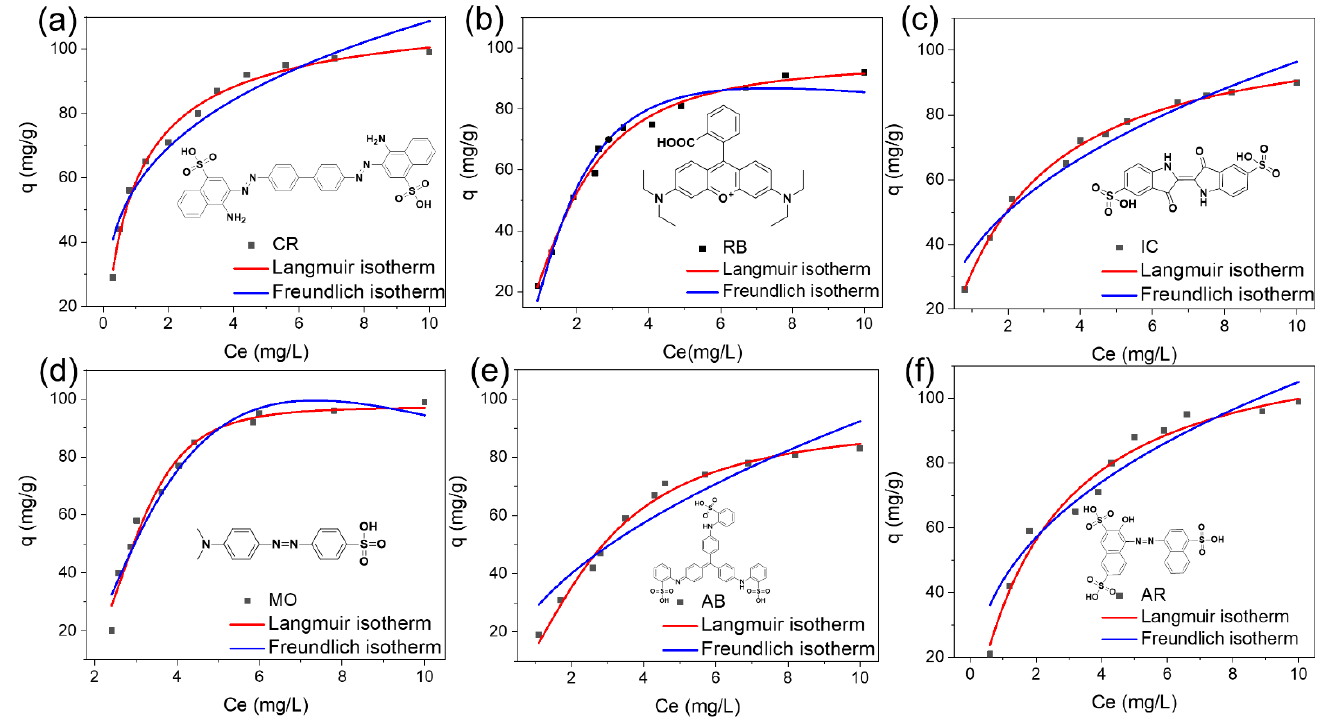
Figure 7. Adsorption isotherms for Congo red ( a ), rhodamine B ( b ), indigo carmine ( c ), methyl or- ange ( d ), acid blue 93 ( e ), and acid red 27 ( f ). orange ( d ), acid blue 93 ( e ), and acid red 27 ( f